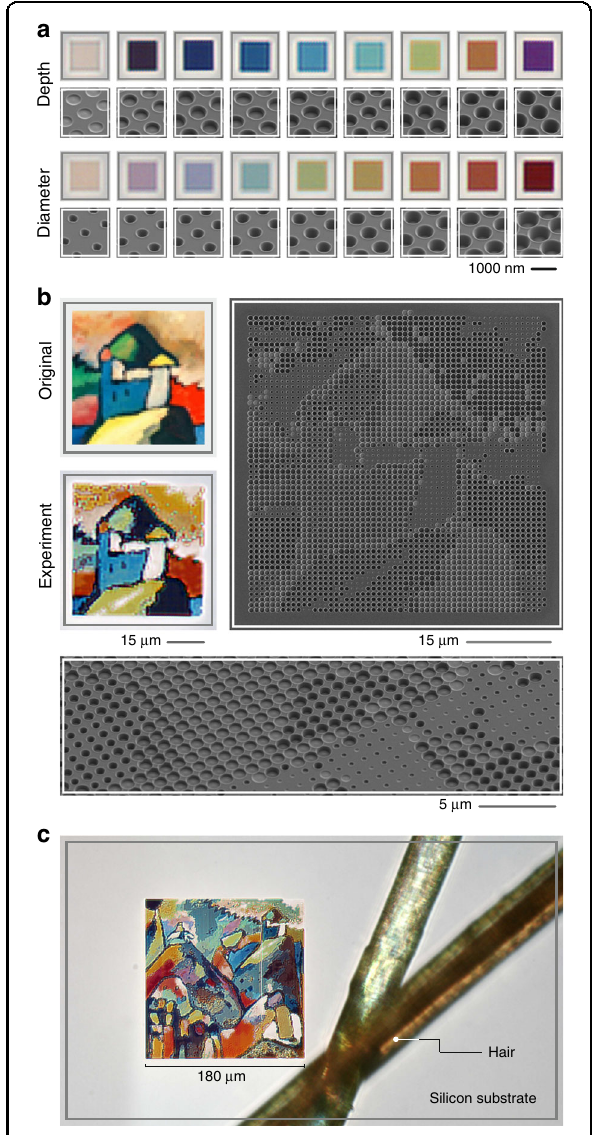
Fig. 5 Colour printing using Mie voids in a silicon substrate at 36.000 dpi. Due to the ideal quality factor and thus linewidth of the Mie void modes, the structures show brilliant and naturalistic colours in re fl ection. Aided by the large interaction cross section, one Mie void is suf fi cient for one pixel . This gives our printing method a pointillistic touch, being completely different from grating-based approaches. a Selected sizes and depth of Mie voids and their colour impression in an optical microscope. b Detail taken from the painting “ Improvisation No. 9 ” by Wassily Kandinsky (Staatsgalerie Stuttgart). The top left depicts the original artwork while the lower left shows an optical microscope image of the colour-printed image. In the SEM image on the right, one can clearly identify the image as the pixel size is unchanged. In order to gain access to the full colour space, the diameter as well as the depth of the Mie voids has been varied, which is particularly well visible in the tilted SEM image. c Fully reproduced “ Improvisation No. 9 ” in a silicon substrate. The image consists of 200 pixelsx200 pixels and has a side length of 180µm, corresponding to 36.000dpi resolution. The image is shown next to a human hair for size